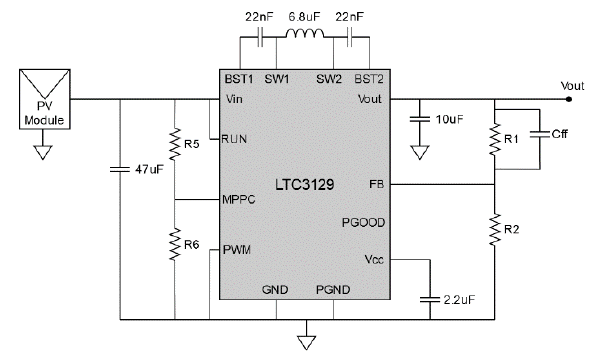
Figure 4. Schematic of the circuit designed using the converter LTC3129 to maximize power extraction from the PV